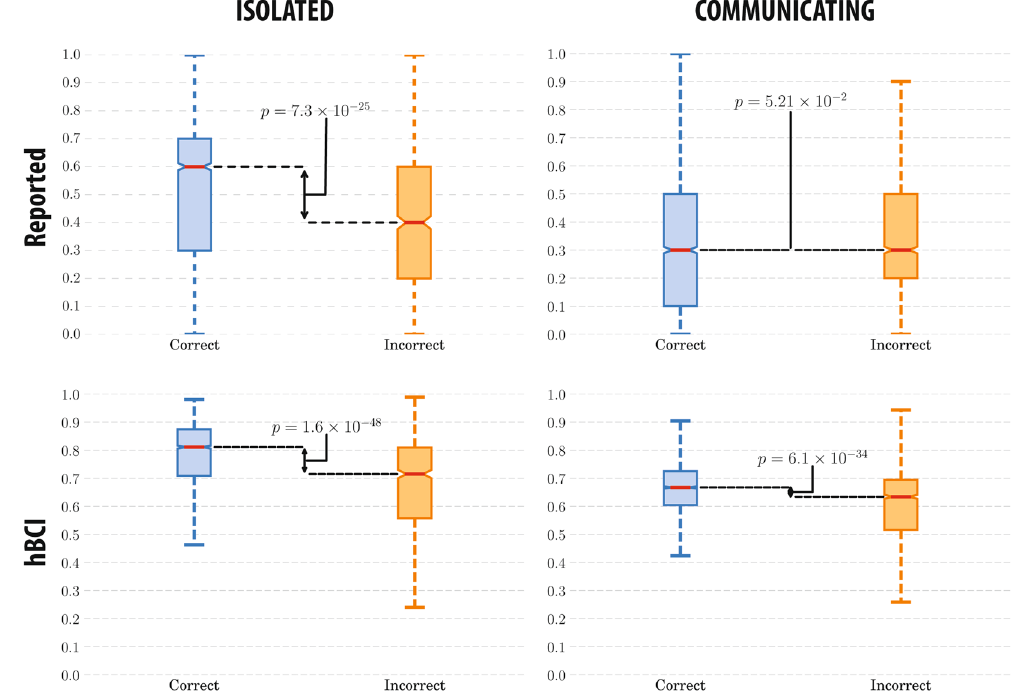
Figure 5. Confidence values indicated by participants (top) and estimated by the hBCI (bottom) for Experiments 1b (left) and 2 (right) for correct and incorrect decisions and corresponding Kruskal-Wallis p -